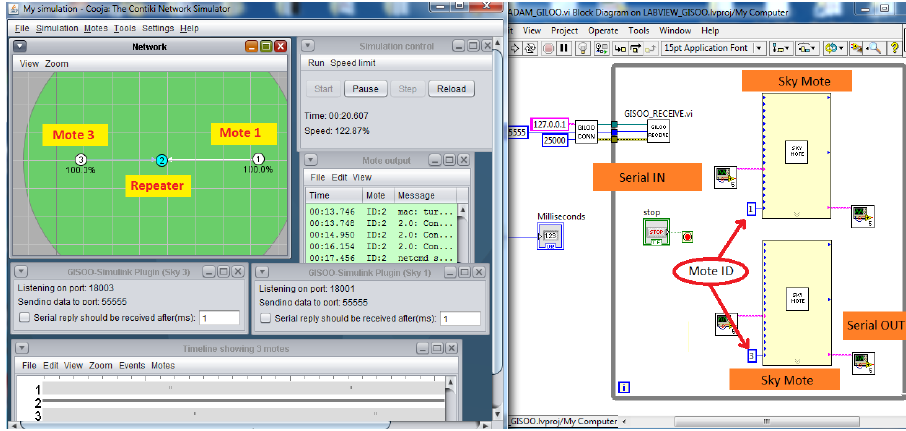
Figure 12. Integration of GILOO module in the control application.